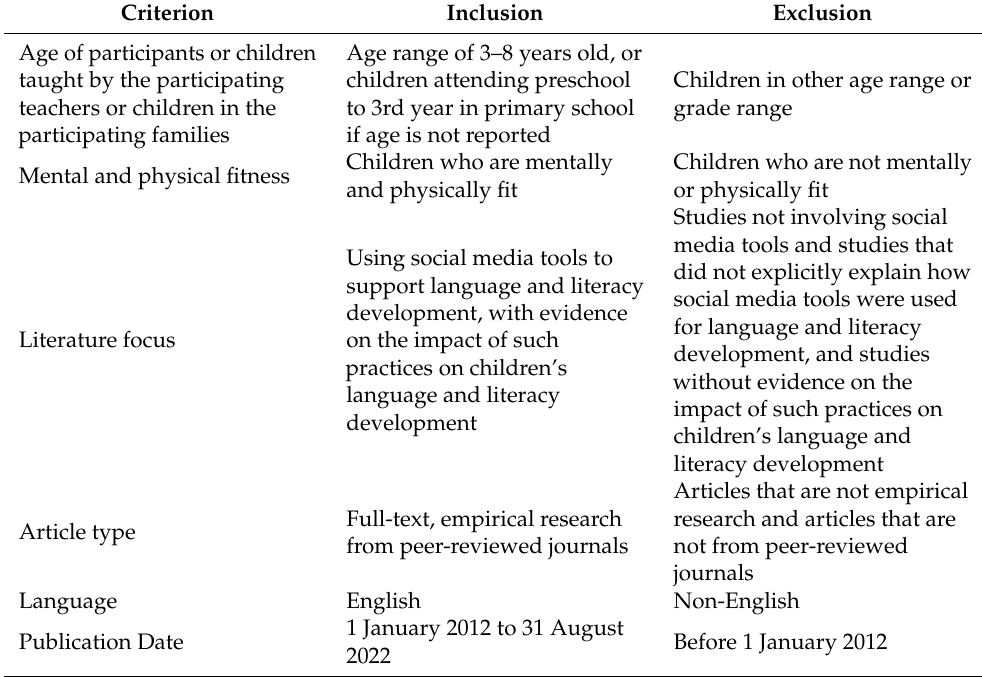
Table 1. Criteria for inclusion and